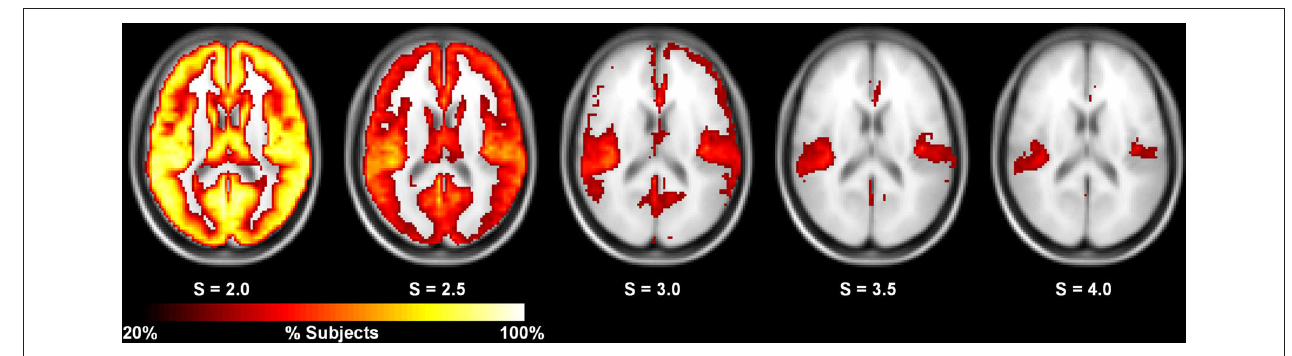
FIguRe 5 | Consistency of high degree nodes (top 25%) across subjects at different thresholds. At S = 2.0, the consistency of high degree nodes is very high across the entire brain. At higher thresholds, this consistency decreases with the high degree cores remaining at the most stringent thresholds ( S = 3.5–4.0).